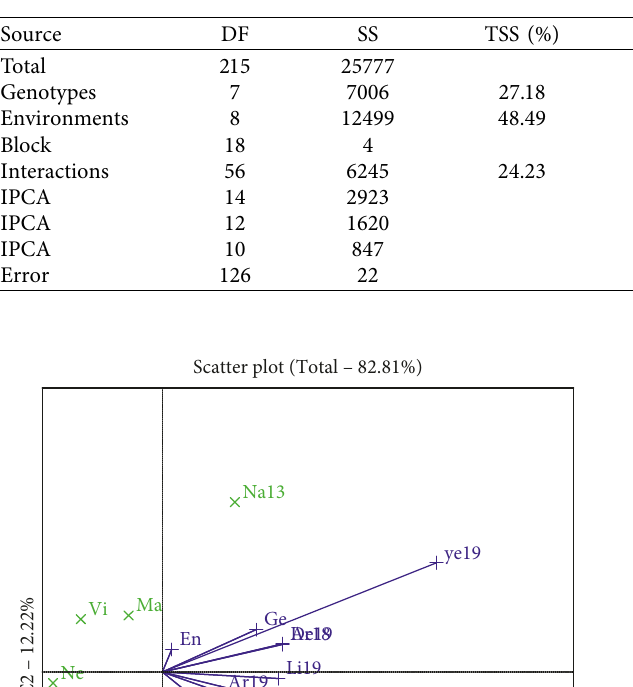
Table 5: ANOVA of AMMI over environments and